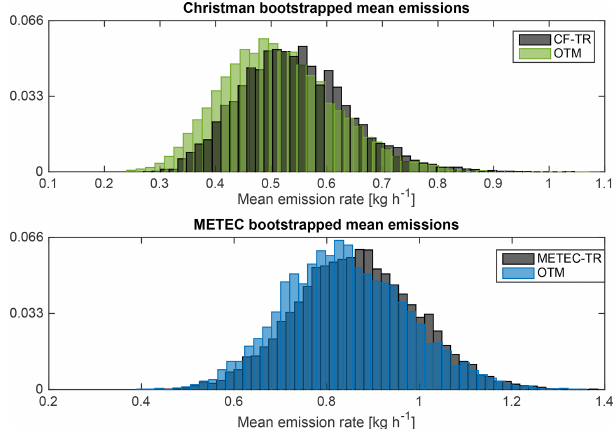
Figure 12. Probability density function (PDF) of bootstrapped mean mass emission flux for OTM measurements and the known releases. Mean and 95% CI in kgh − 1 are as fol- lows. Christman: known release – ( 0 . 54 ( 0 . 37 , 0 . 75 )) , OTM – ( 0 . 51 ( 0 . 34 , 0 . 73 )) . METEC: known release – ( 0 . 85 ( 0 . 58 , 1 . 13 )) , OTM – ( 0 . 84 ( 0 . 60 , 1 . 11 )) .